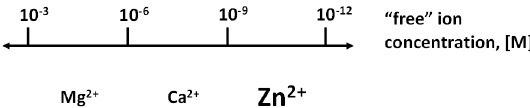
Figure 1. Biological regulation with the three redox-inert metals ions: Mg 2+ , Ca 2+ , and Zn 2+ . Zinc extends the range of regulation with metal ions. The regulatory function of each metal ion is in a specific range of concentrations, thus avoiding overlap with the signalling functions of the other metal ions. However, there are interactions among the metabolism of the metal ions.